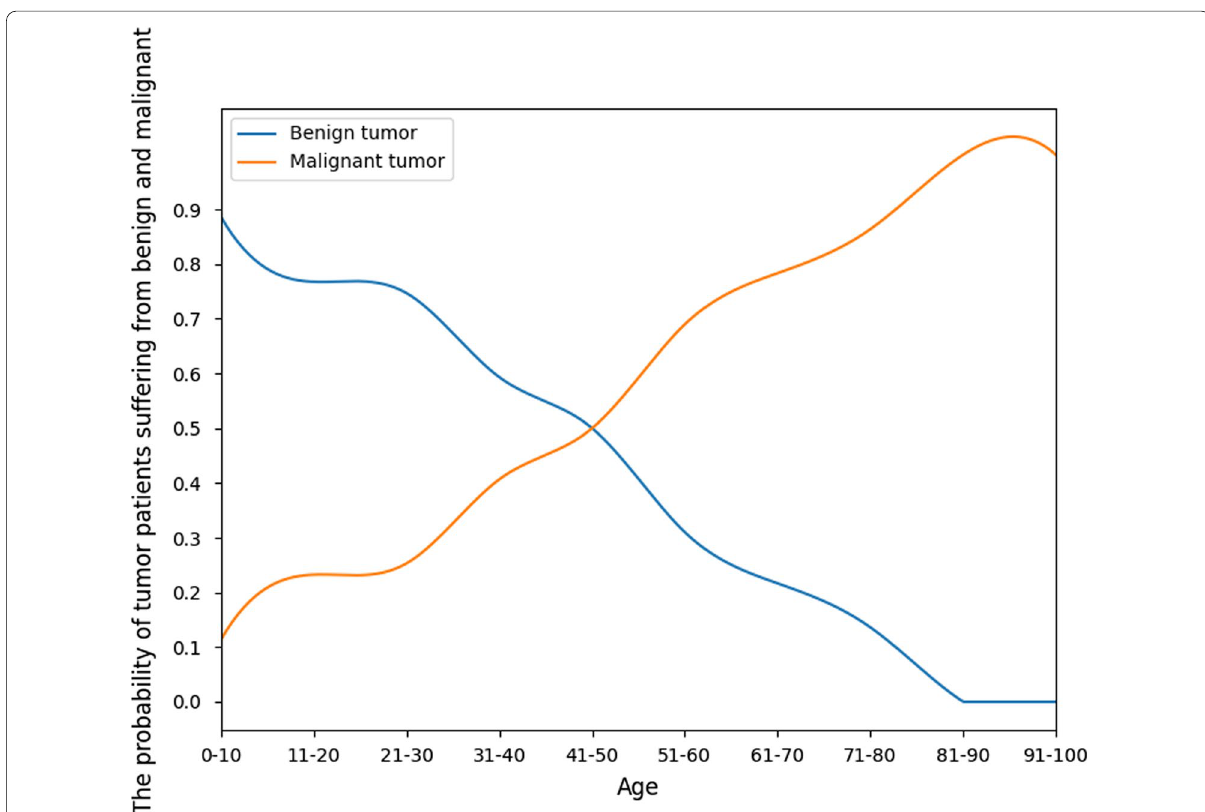
Fig. 5 The probability of benign and malignant tumors with different